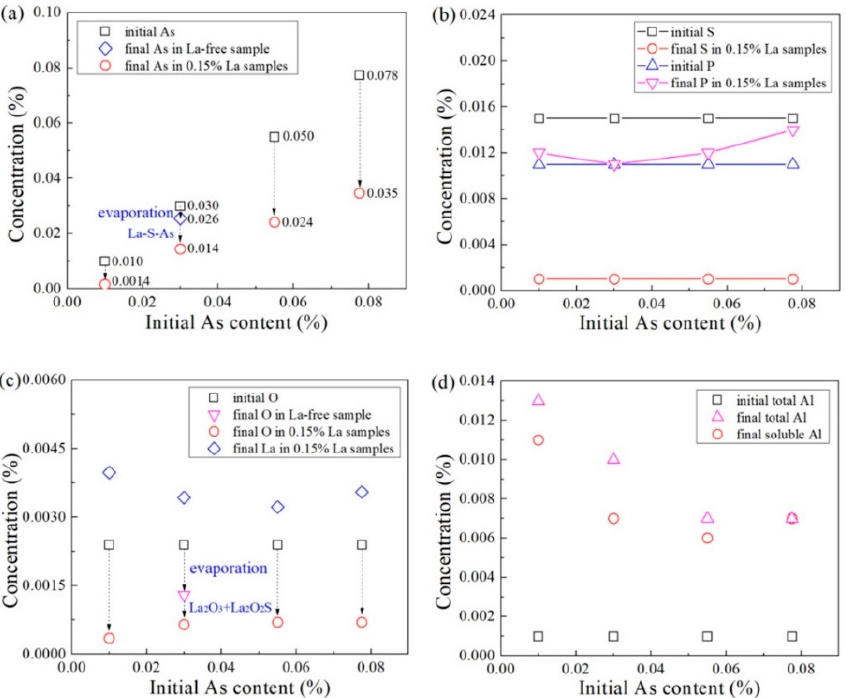
Figure 8. Chemical composition changes of alloys with La addition. ( a ) Arsenic concentrations; ( b ) concentrations of sulfur and phosphorus; ( c ) concentrations of oxygen and lanthanum; ( d ) concentrations of total and acid-soluble aluminum.